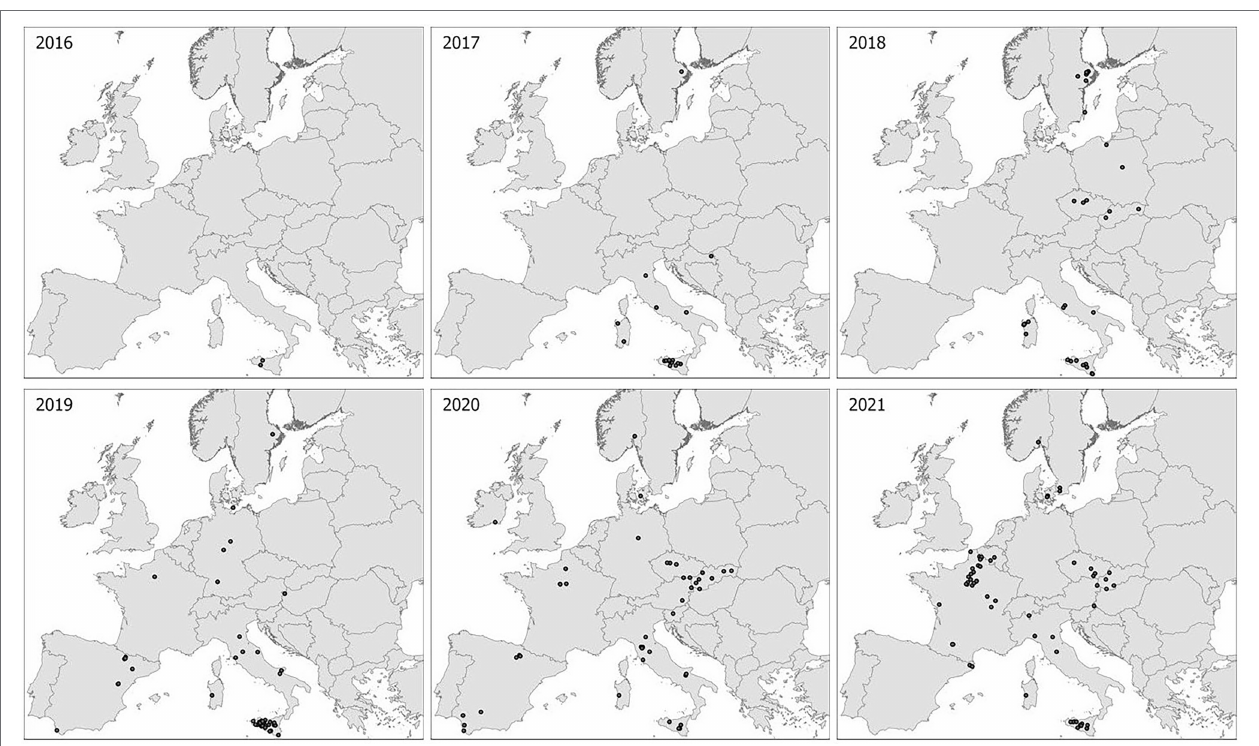
FIGURE 1 | Sampling sites in Europe 2016–2021. Each dot represents a sampling site where one or more samples were collected for genotype/race analyses. Additional sampling sites near Omsk and Novosibirsk in Western Siberia not